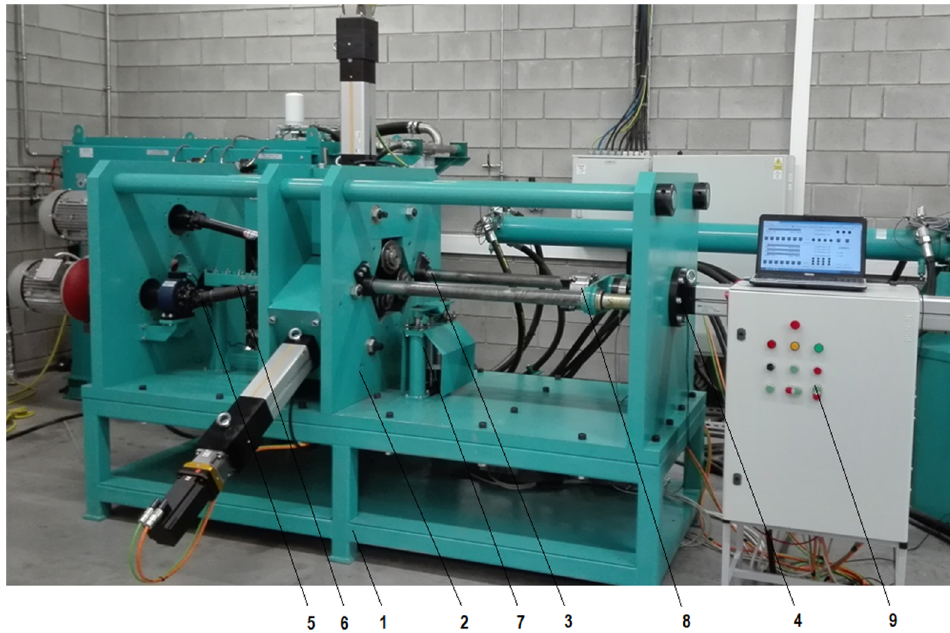
Figure 4. The skew rolling mill with numerically controlled movement of rolls and gripper: support frame—1, drive unit—2, work roll cage—3, axial shift unit—4, drive transmission unit—5, batch support unit—6, the gripper group—7, the rolled forging support unit—8, and the power and control system—9.